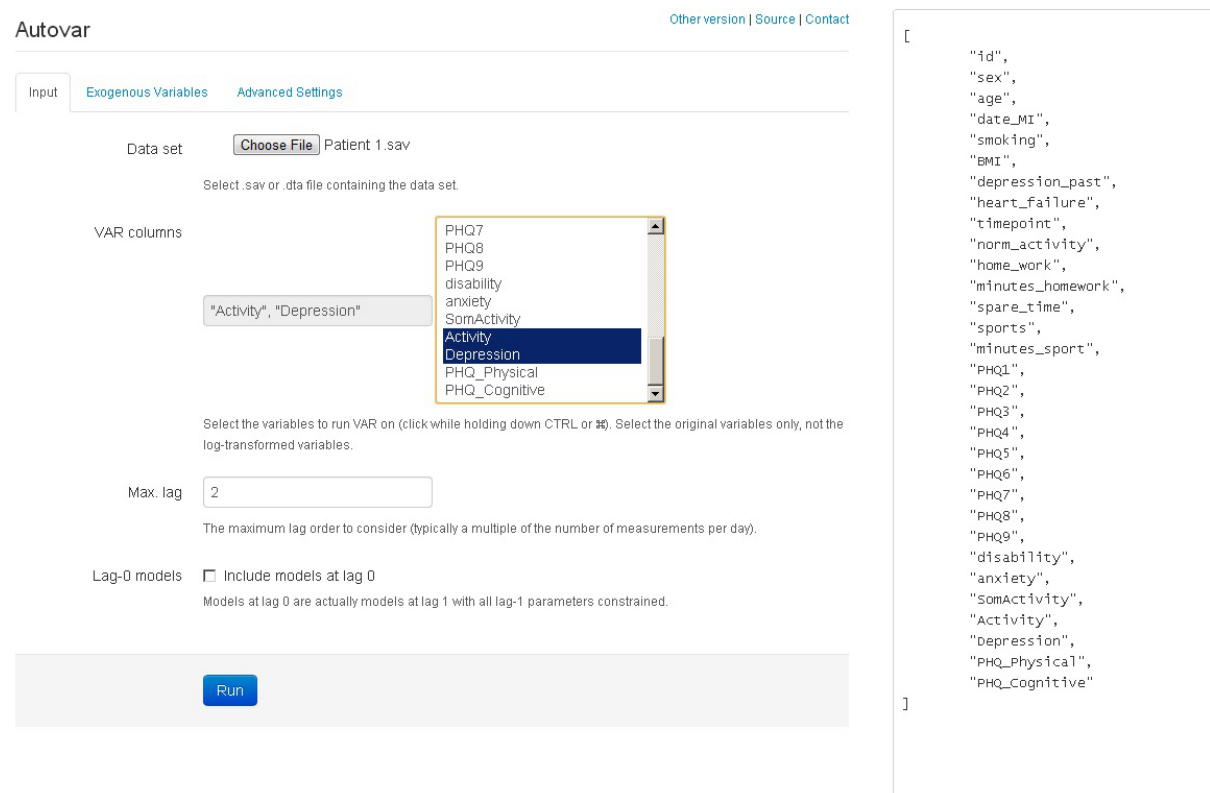
Figure 1. AutoVAR screenshot.